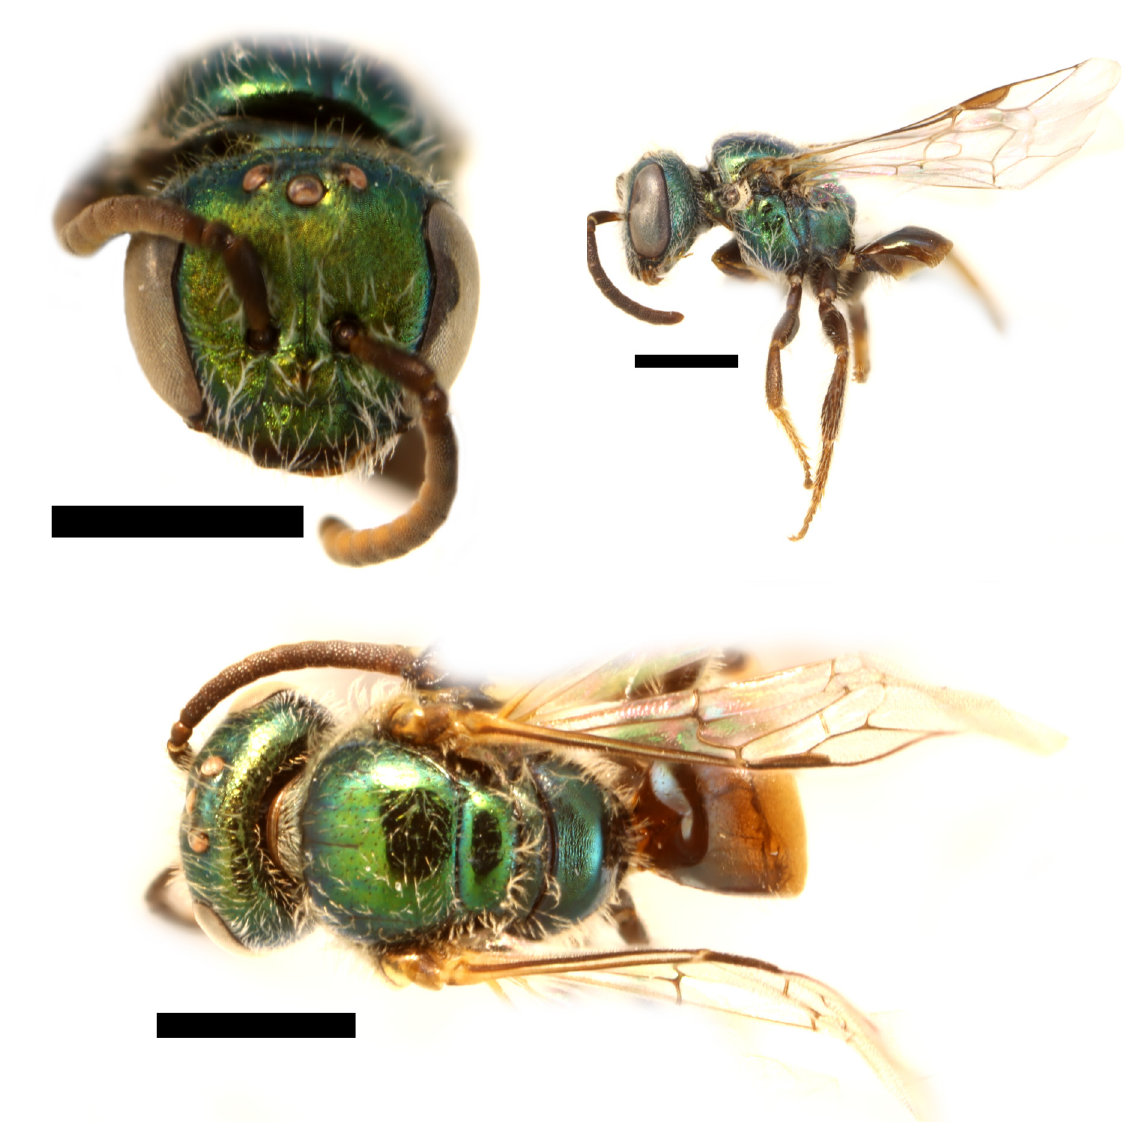
Fig. 28. Lasioglossum rufopanticis (Engel, 2001), ♂. A . Face. B . Lateral habitus. C . Dorsal habitus. Scale bars = 1